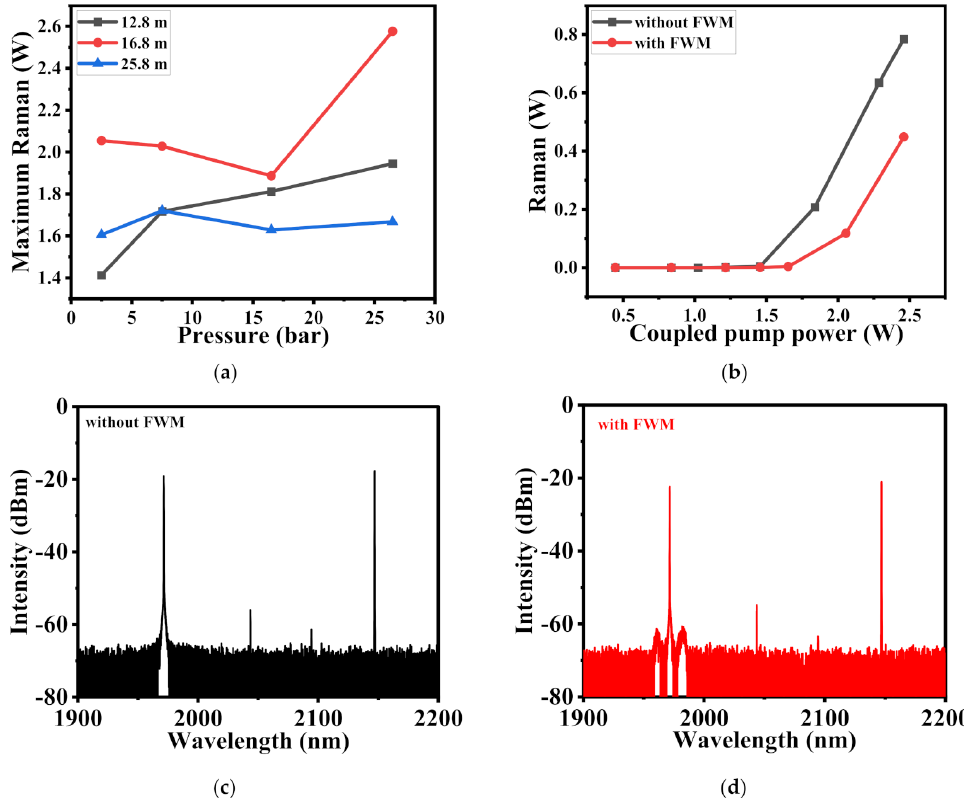
Figure 8. ( a ) Maximum Raman power under different fiber lengths and pressures; ( b ) Raman power with respect to the coupled pump power with & without FWM; the spectrum ( c ) without FWM & ( d ) with